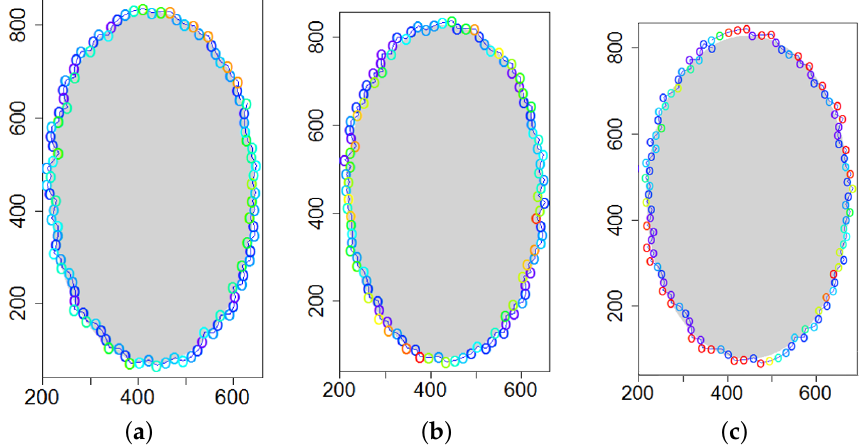
Figure 10. Successive D P positions during cloud boundary tracking calculated for three variants of m (cid:101) χ updating procedures: ( a ) variant III, ( b ) variant IV, ( c ) variant V; simulation scenario Cloud 2 . The colors of the points correspond to different values of (cid:101) χ